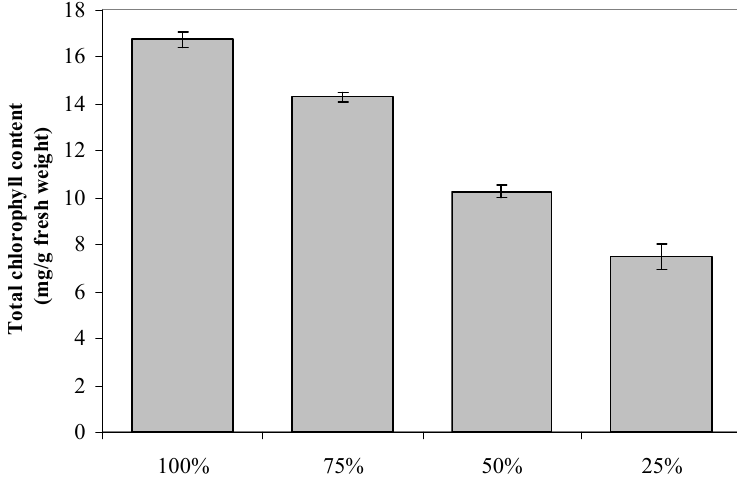
Figure 1. The effects of different evapotranspiration replacement on chlorophyll content of L. pumila . N = 60. Bars represent standard error of differences between means